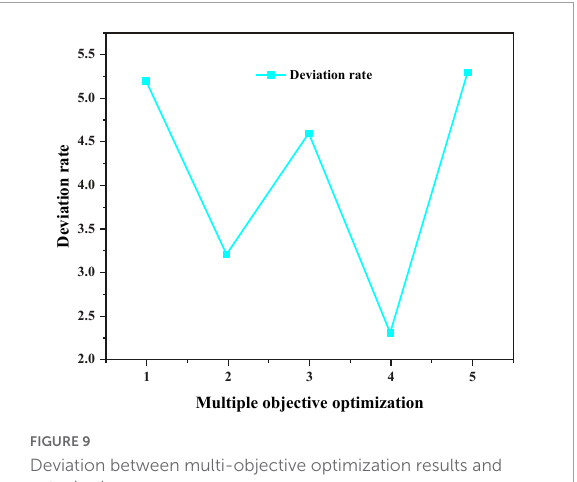
FIGURE9 Deviation between multi-objective optimization results and actual